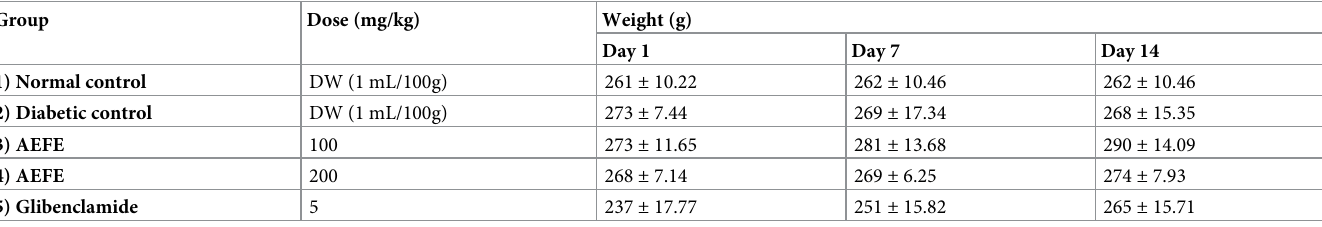
Table 7. Effect AEFE on body weight of HFD-STZ induced diabetic rats.